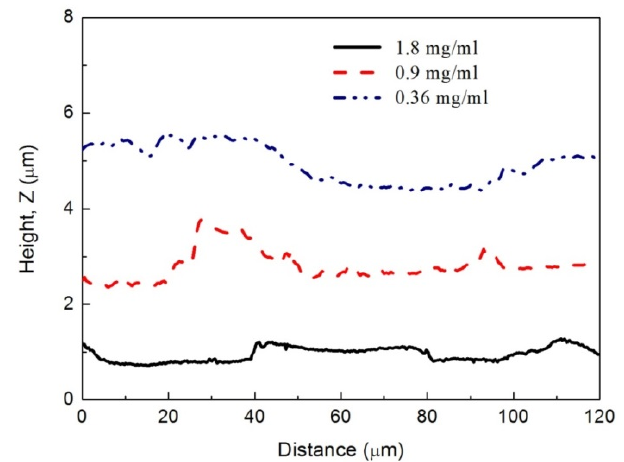
Figure 8. The effect of precursor concentration on the profile of spray-on P3HT:PCBM films fabricated using 15 deposition passes, with a carrier air pressure of 0.2 MPa, and a flow rate of 1 mL/min. The y -axis is to show the surface profiles only, and it cannot be used to estimate the film